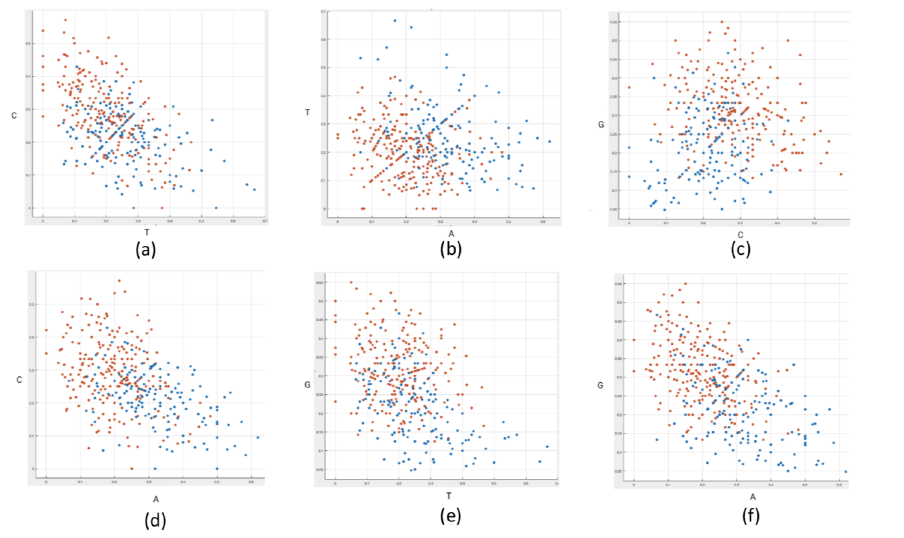
Figure 7. Representation of the sub-sequences on the plane based on the relative frequencies of two nucleotides. Each sub-sequence is represented by a dot on the plane. More specifically, the relative frequency of thymine and cytosine ( a ), adenine and thymine ( b ), cytosine and guanine ( c ), adenine and cytosine ( d ), thymine and guanine ( e ), and adenine and guanine ( f ), respectively, is shown. The colors represent the speed of translation: orange and blue dots indicate slow and fast sub-sequences, respectively.